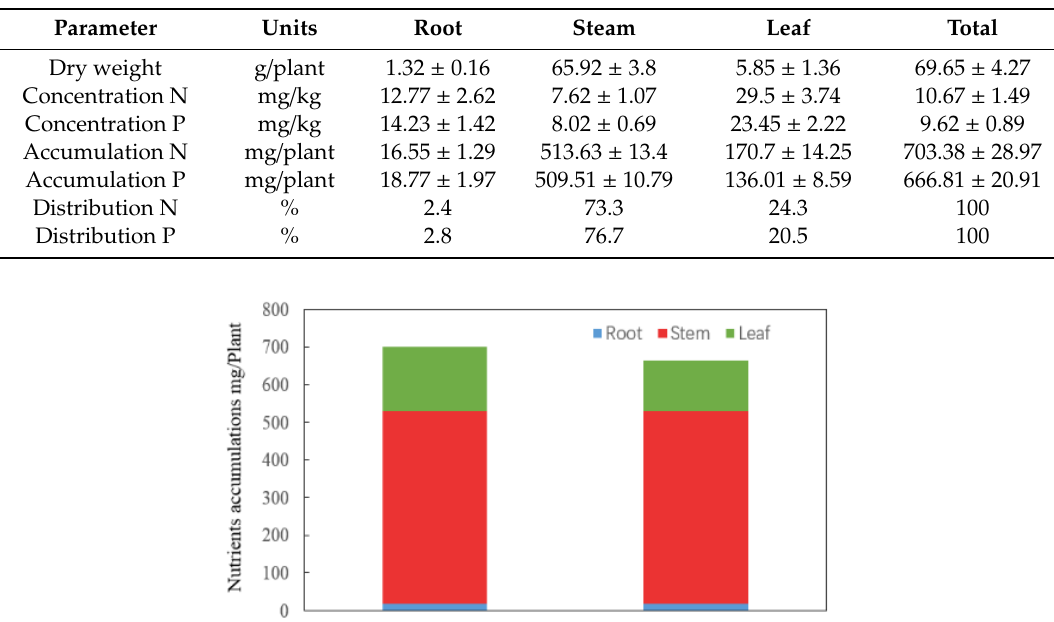
Table 2. The plant growth and nutrient contents in the leaves, stems, and roots of shrub willow ( Salix spp. ).